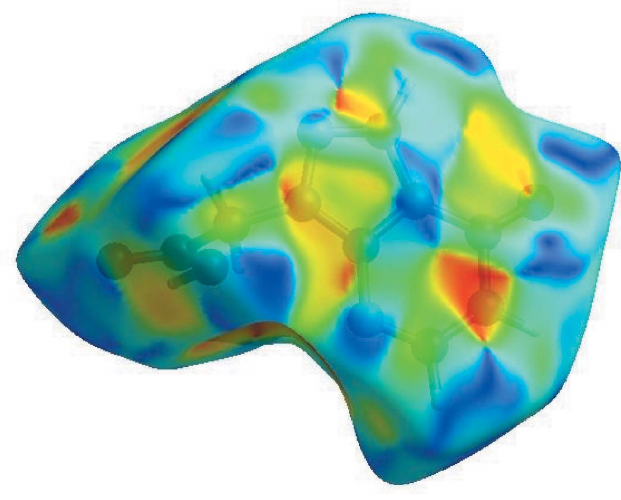
Figure 5 Hirshfeld surface of the title compound plotted over shape-index.